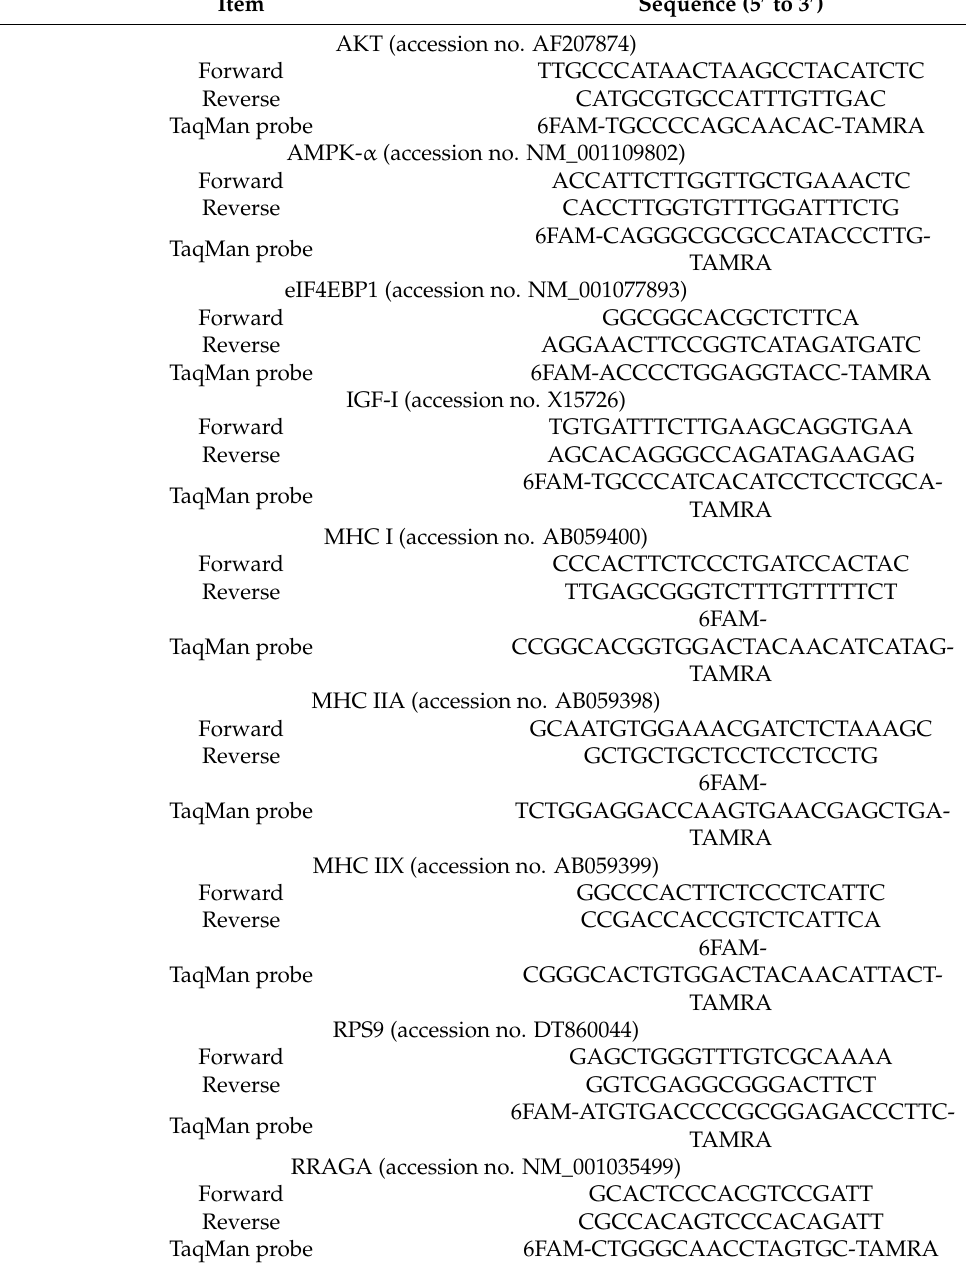
Table 3. Sequence for bovine PCR primers and TaqMan probes for myogenic genes 1